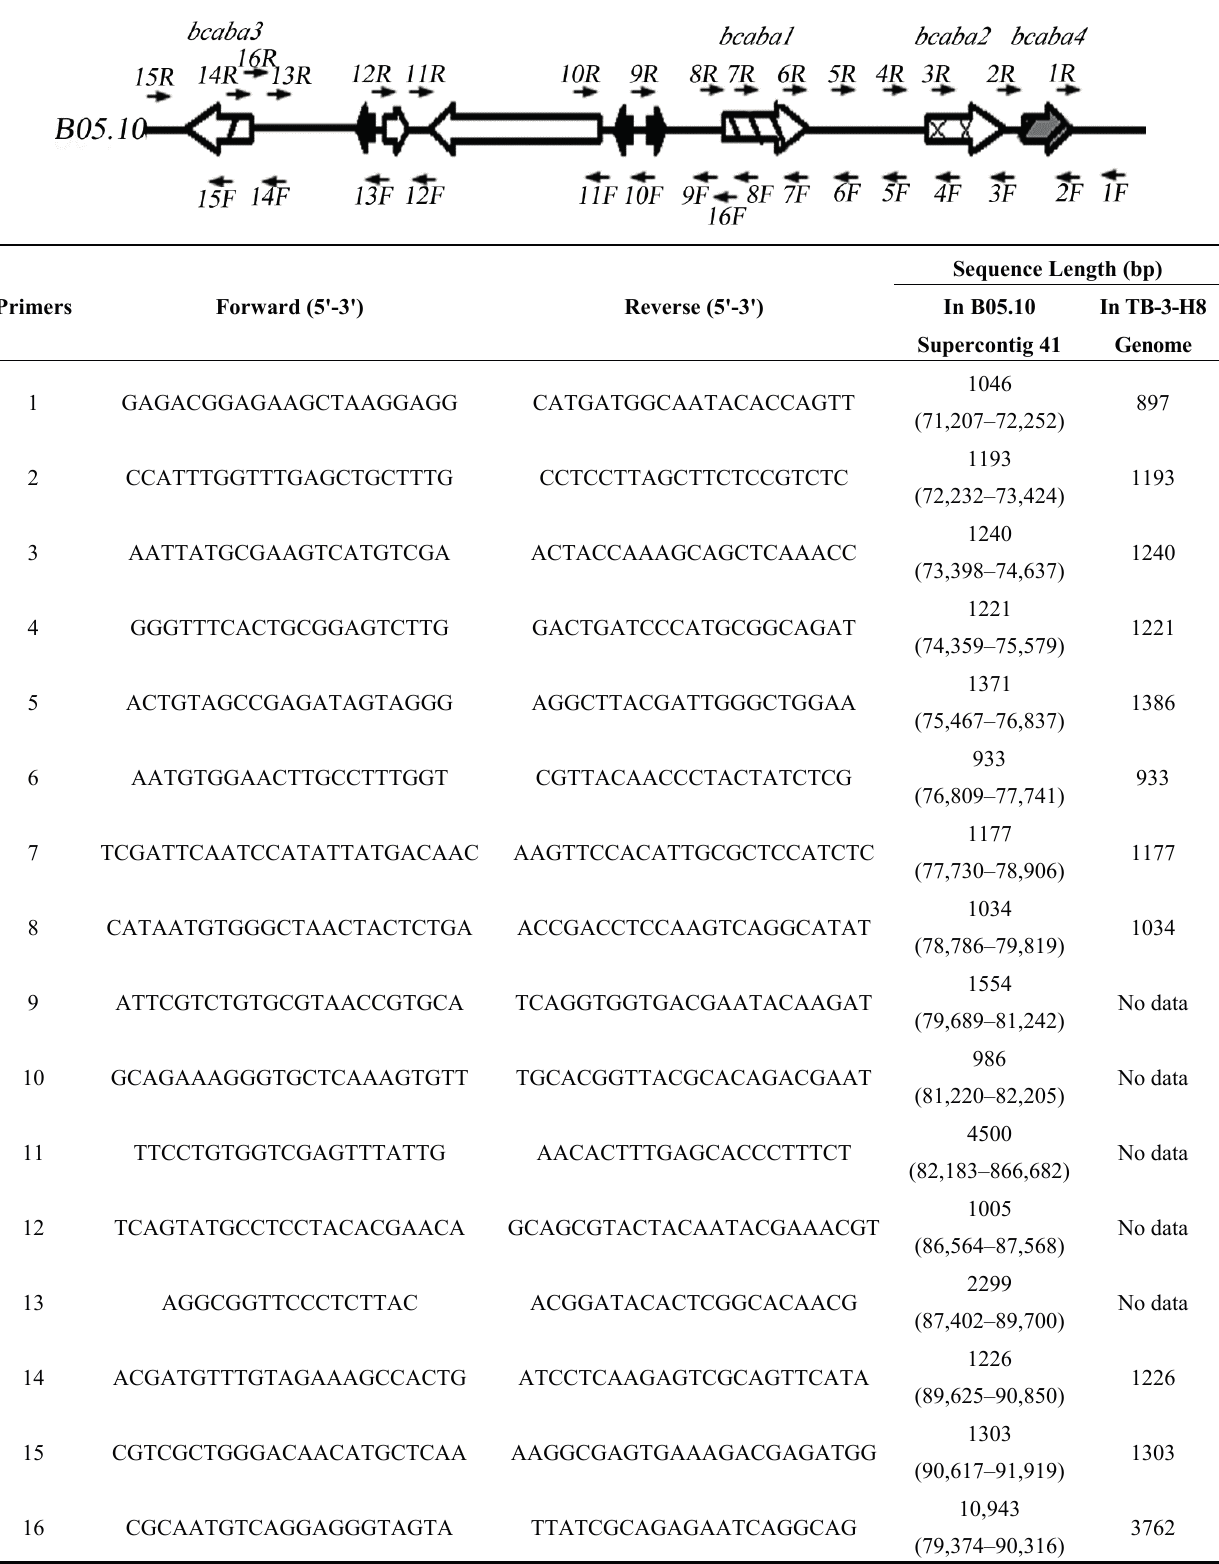
Figure 2. Primer pairs designed according to the sequence in the B . cinerea B05.10